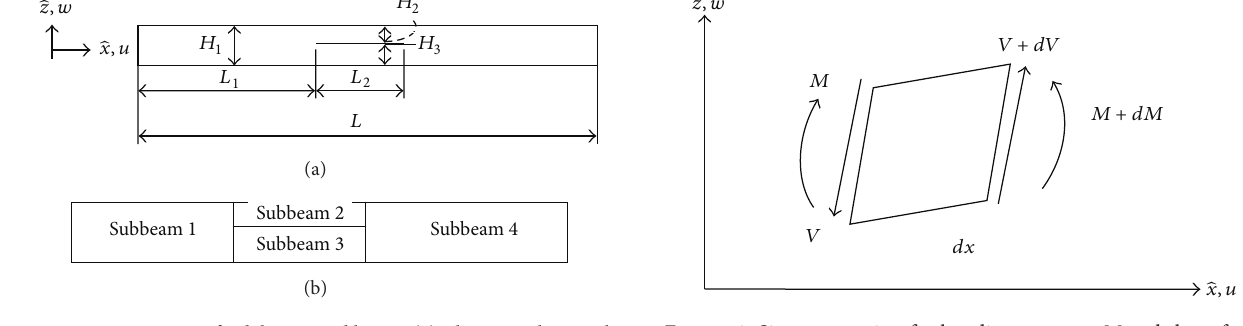
Figure 1: Geometry of a delaminated beam: (a) a beam with a single delamination and (b) four interconnected subbeams.